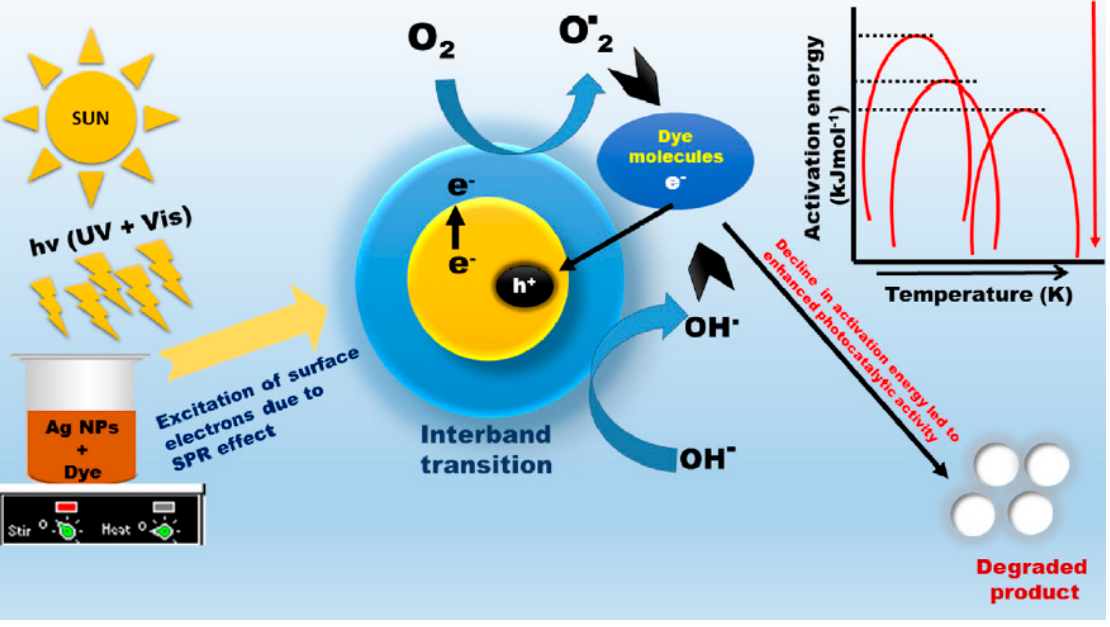
Figure 10. Diagrammatic representation for the suggested mechanism of photocatalytic dye degradation by biogenic silver nanoparticles and correspondingly explaining the activation energy role. Reproduced from Reference [124], with permission from Elsevier, 2019.